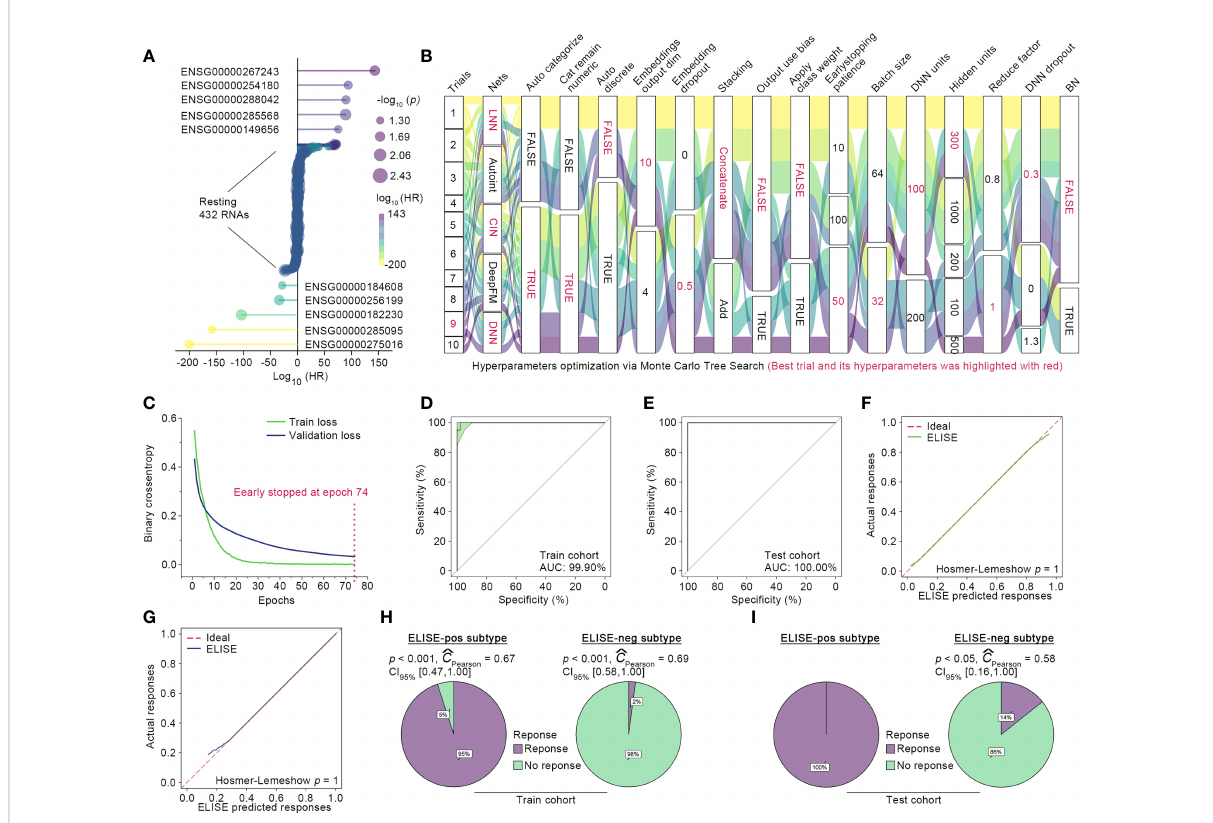
FIGURE 2 ELISE applied to EACs. (A) Resultant data of feature selection. (B) Hyperparameter optimization. (C) Loss curves of the best trial. (D, E) presented AUCs of ELISE in the train and test cohort. (F, G) are the calibration plot of ELISE in the train and test cohort, respectively. (H, I) displayed the actual outcomes distribution in the ELISE-neg and ELISE-pos